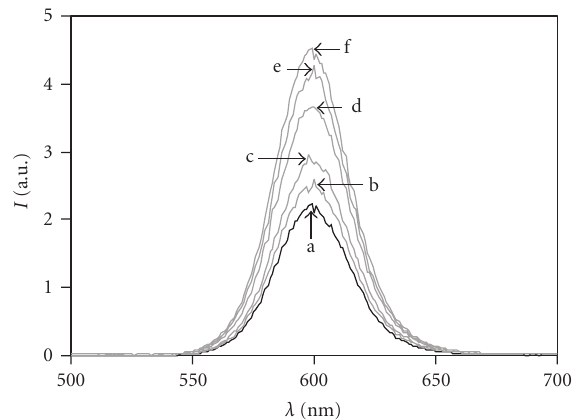
Figure 1: Emission spectra of CdSe-ZnS core-shell QDs (0.1 μ M in borate bu ff er, pH = 7.4, T = 20 ◦ C, λ EX = 442 nm) coated with DHLA in the absence (a) and presence of 0.5 (b), 1.0 (c), 2.0 (d), 5.0 (e), and 10.0 (f) μ M of His 6 -PDK1( Δ